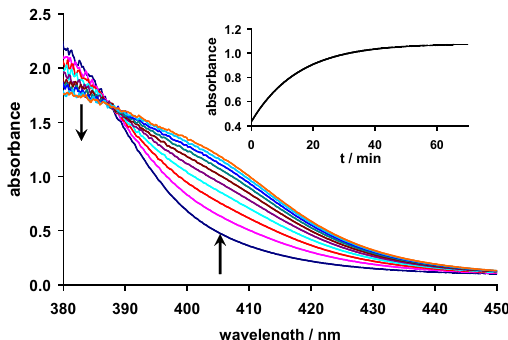
Figure 1. Illustration of the oxidative addition reaction between CH on the IR spectrophotometer between 1650 – 2200 cm -1 in chloroform at 25ºC. (a) The first reaction (left, 90 s intervals) is indicated by the disappearance of Rh I (peak at 2018 cm -1 ) and the simultaneous appearance of Rh III -alkyl (peak at 2108 cm -1 ) at the same rate. (b) The second reaction is indicated by the simultaneous disappearance of Rh III -alkyl (peak at 2108 cm -1 ) and the formation of an Rh III -acyl (peak at 1714 cm -1 ) species. The inserts give the absorbance vs. time data of the indicated species. [CH